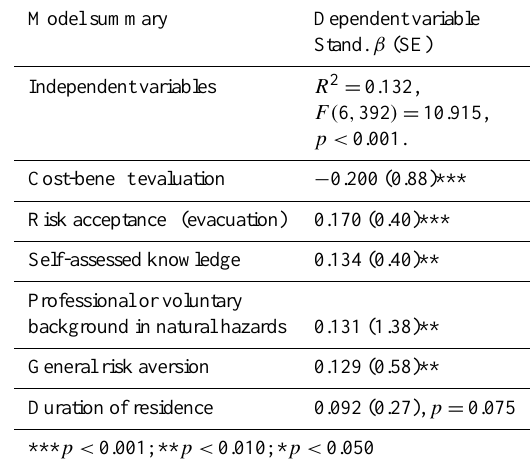
Table 4. Predictors of current state of preparedness (already adopted